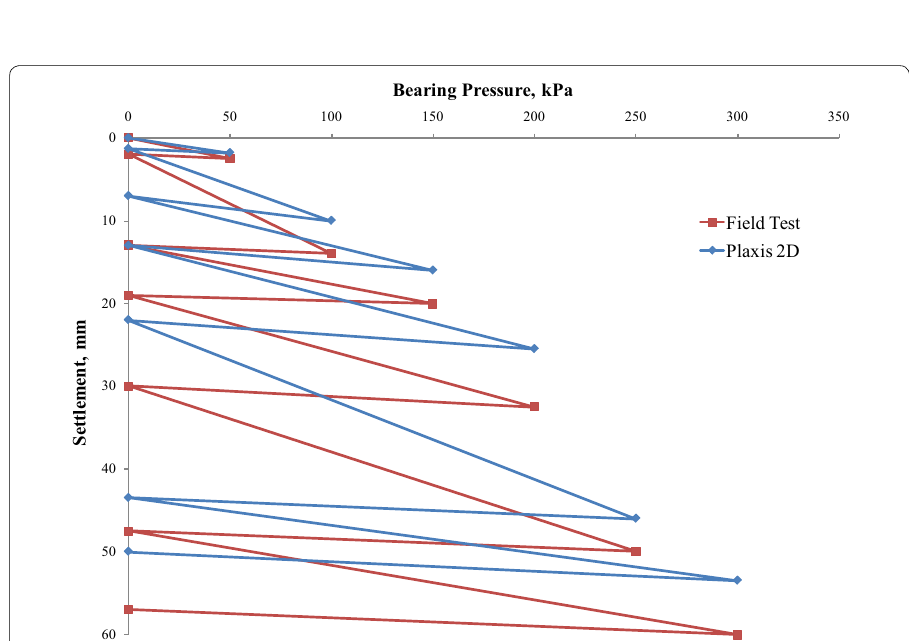
Fig. 16 Bearing pressure-settlement response for 60 cm plate